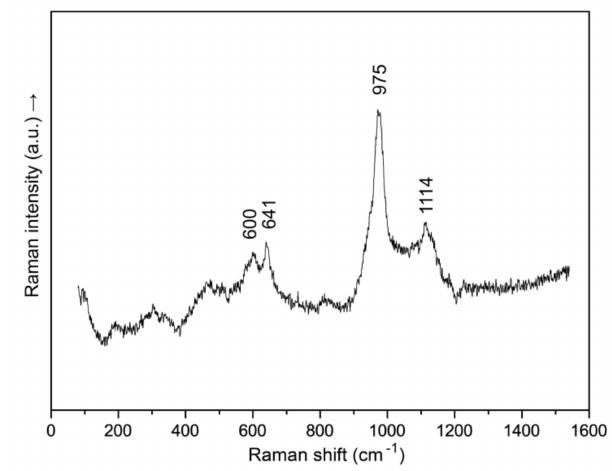
Figure 4. The Raman spectrum of xenophyllite (analysis 1 in Table 5).